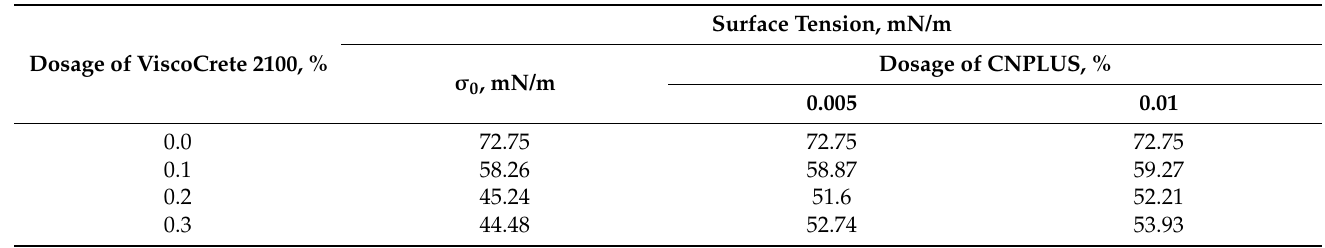
Table 4. Dependence of surface tension on the concentration of ViscoCrete 2100 and CNPLUS.